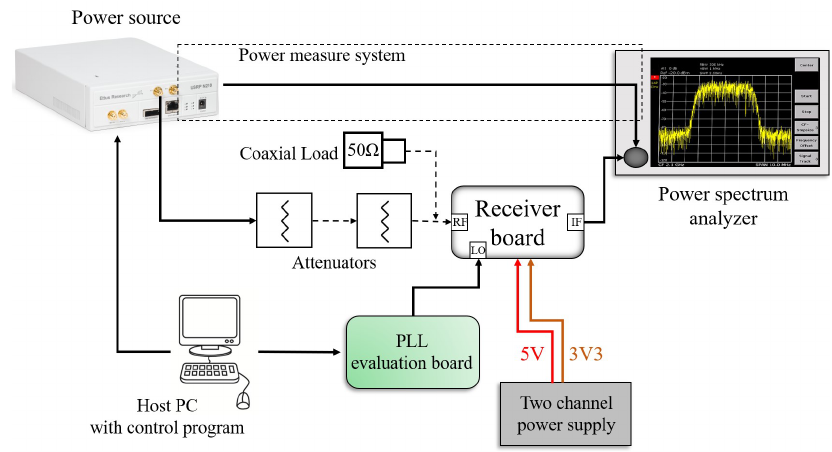
Figure 8. General scheme adopted for the board-level functional tests executed for the RF receiver.